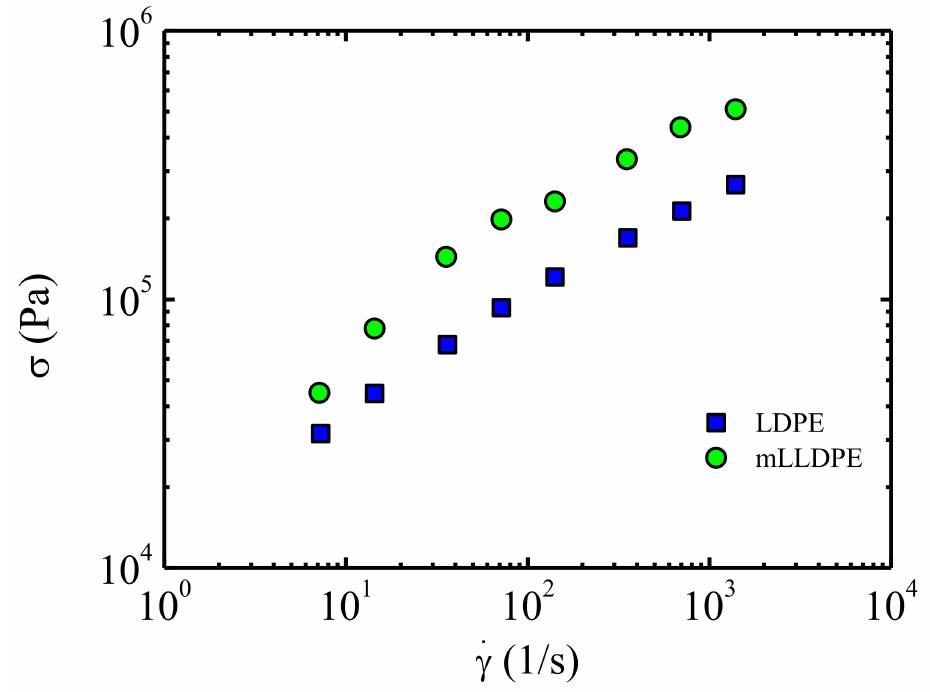
Figure 3. Flow curves of mLLPE and LDPE obtained by extrusion flow at 190 ◦ C (“m” stands for metallocene-catalysed polyethylene; see text) [21] Reprinted with permission from [21]. Copyright 2005 Elsevier